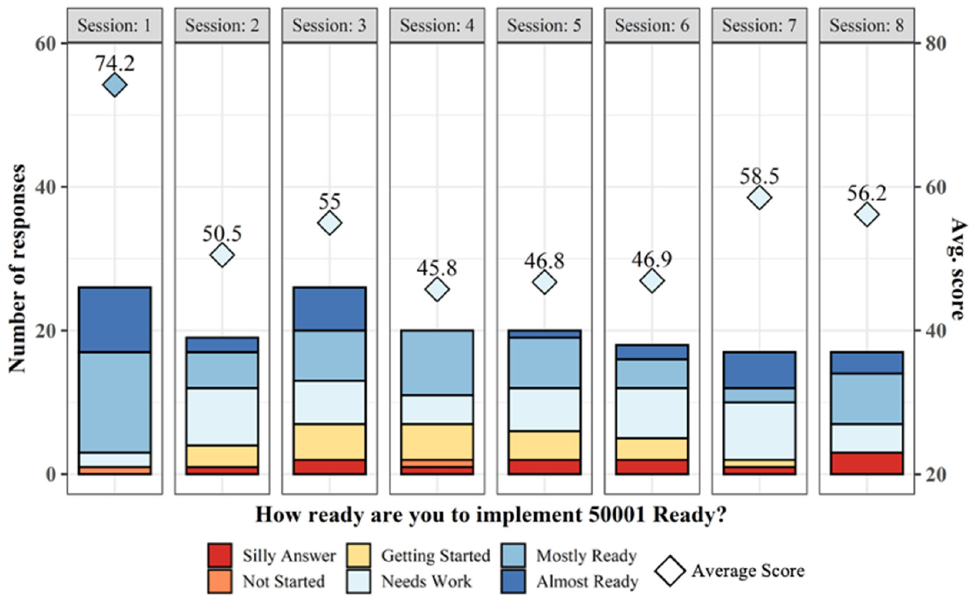
Figure 7. Responses to “How do you feel about 50001 Ready helping you with your energy management plans?” (source: based on the polling survey results).